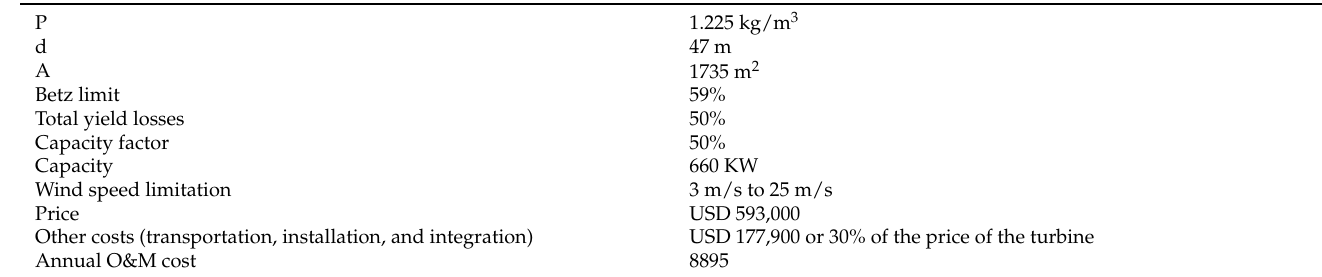
Table A1. 660 KW Vestas V47 Specifications.